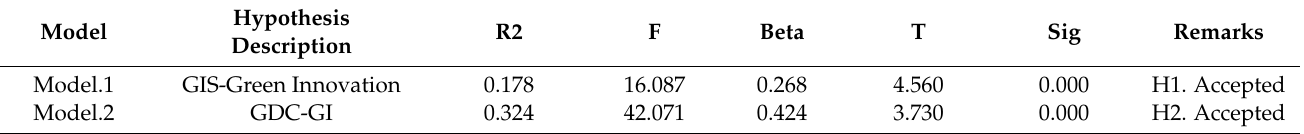
Table 4. Results of direct-effect testing (H1, H2).